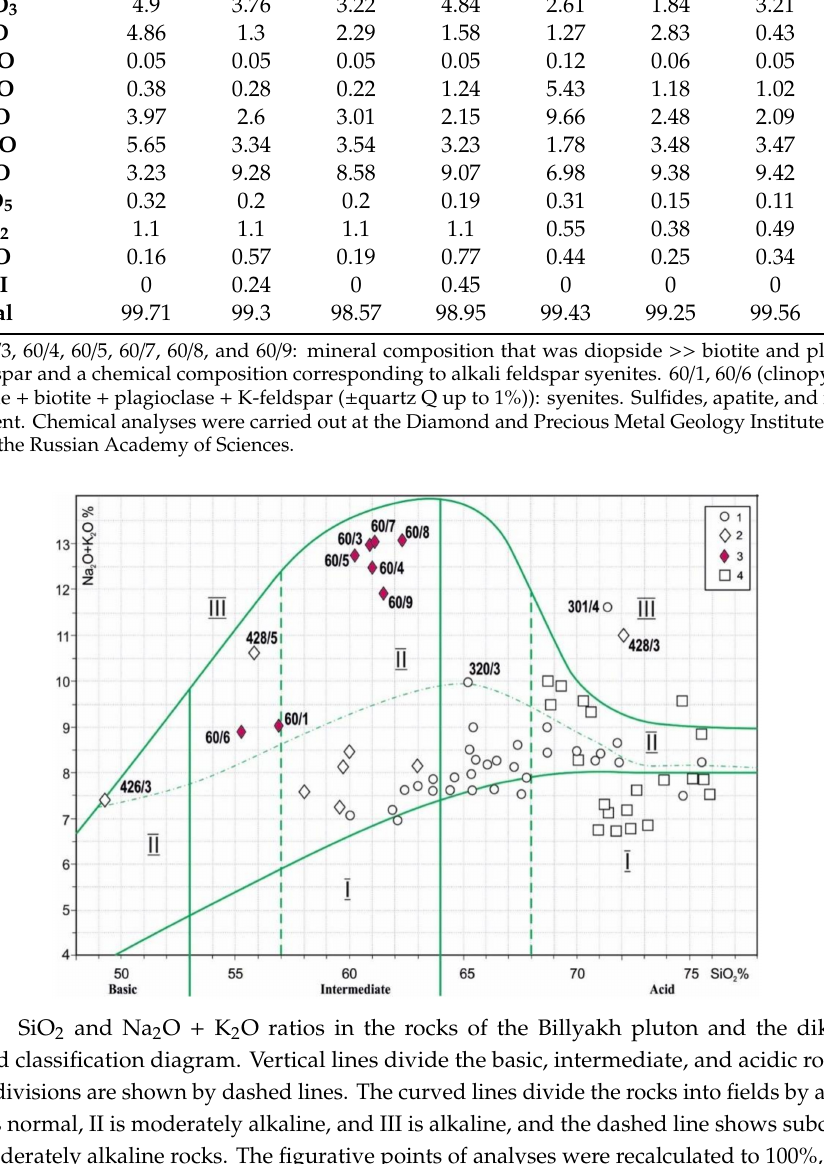
Table 1 and some samples from A.P. Smelov mentioned in the text are